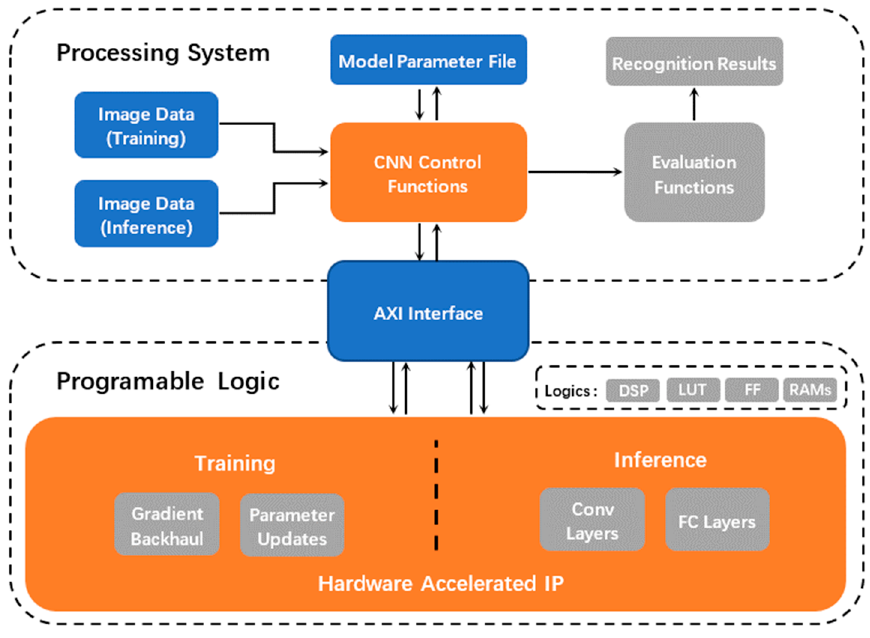
Figure 2. Overall architecture of the system.